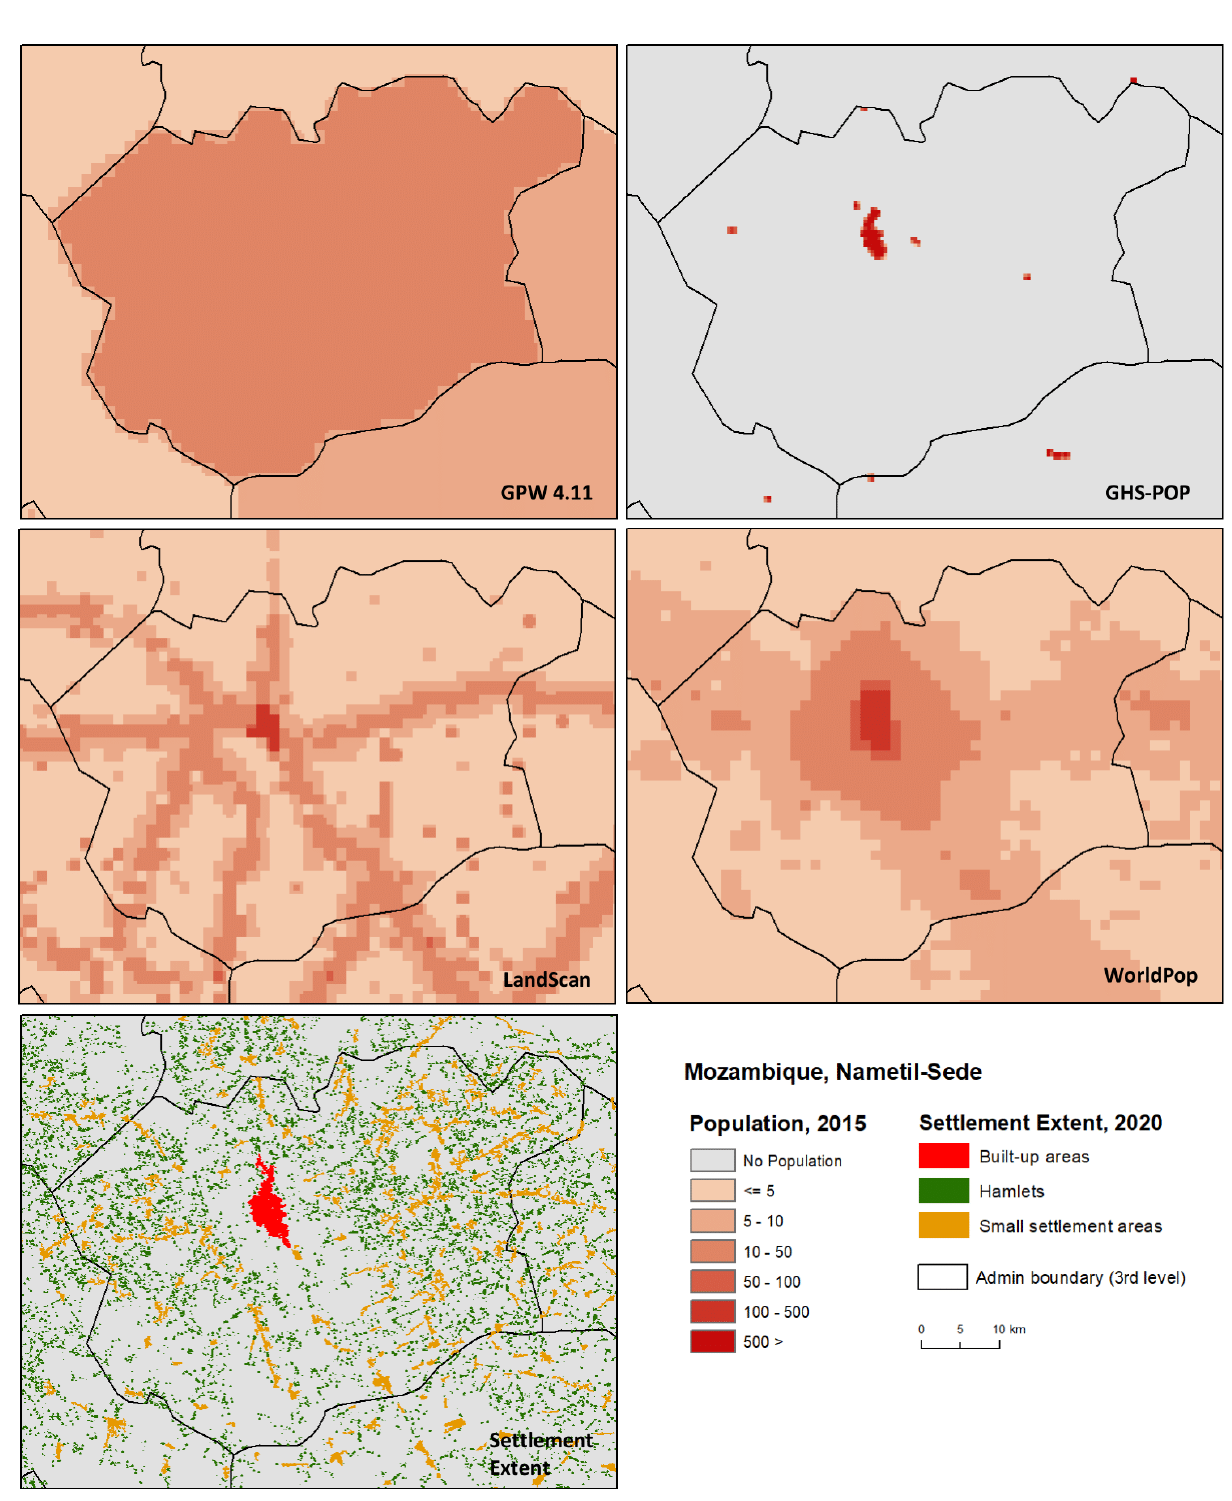
Figure B10. Comparison of population distributions by population data sources shown with administrative boundaries and GRID3 building- footprint-derived settlement extent data, Nametil-Sede and surrounding